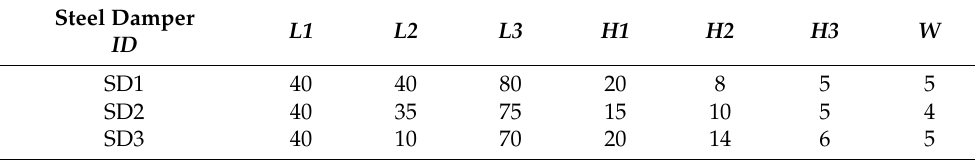
Table 9. Dimensions for steel dampers (mm).